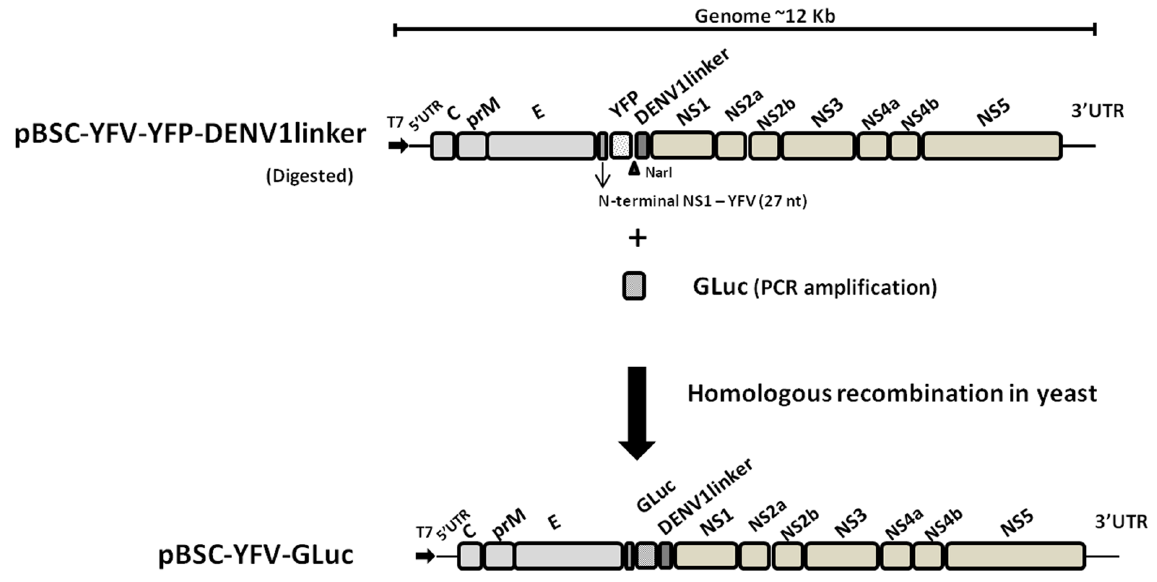
Figure 1 - Schematic representation of YFV-GLuc virus construction. pBSC-YFV-YFP-DENV1linker was digested with NarI restriction enzyme and the Gaussia luciferase (GLuc) reporter gene was amplified with recombination oligonucletides (YFV- GLuc-F and YFV-GLuc-R) (Table I). The GLuc PCR product with homologous terminal sequences to NarI -linearized